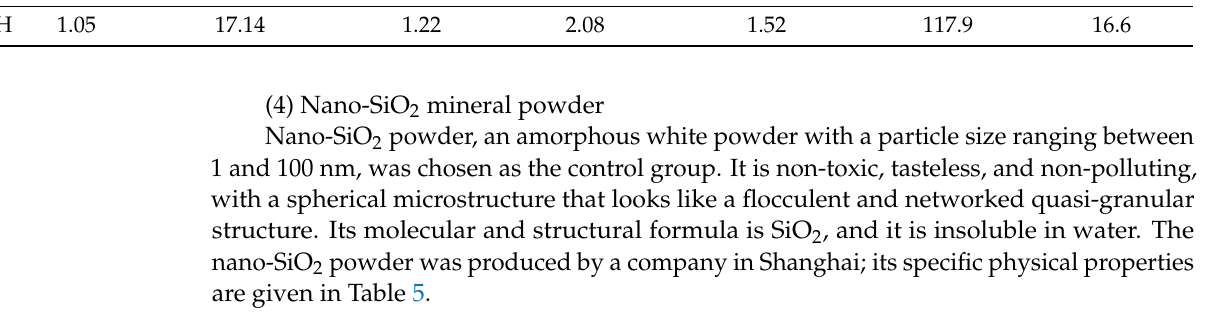
Table 5. Physical Properties of Nano-SiO 2